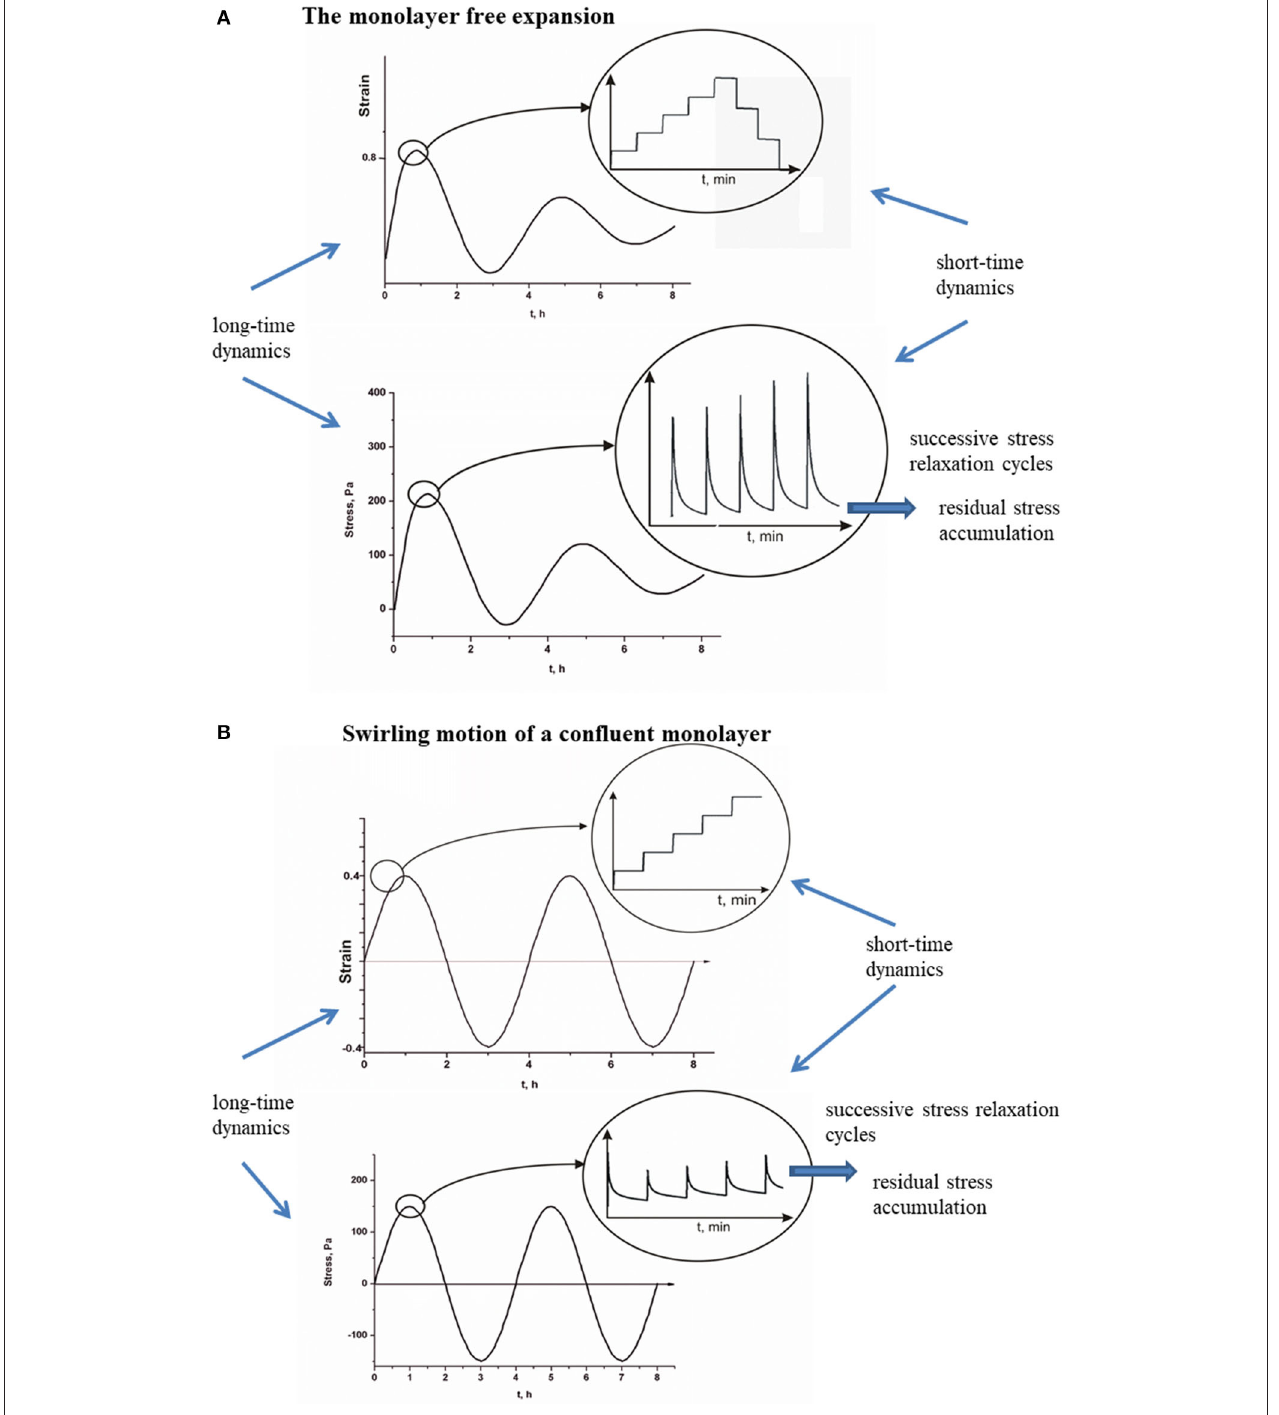
FIGURE 2 | (A,B) Short-time relaxation cycles of cell stress and long-time residual stress accumulation for propagative and standing waves.